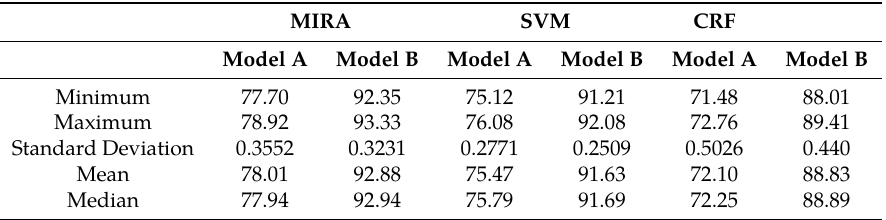
Table 14. Measure of